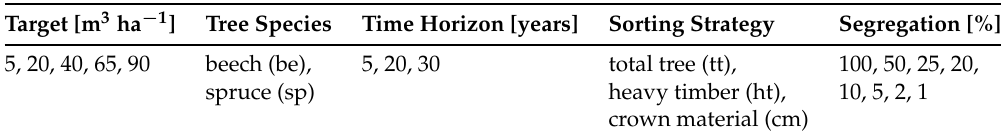
Table 3. Parameters for the construction of the deadwood scenarios. All available combinations sum up to a set of 720 possible